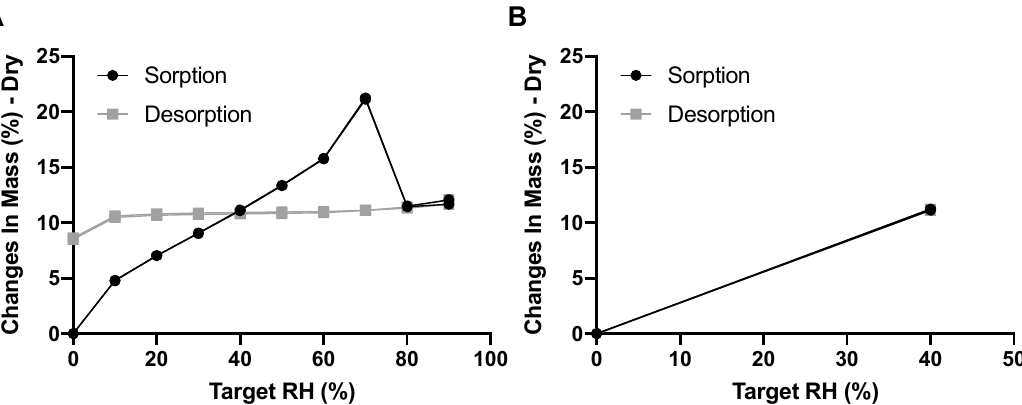
Figure 2. The DVS results for the amikacin formulation—panel ( A ) shows the sorption and desorption data from 0% to 90% RH and back in steps of 10% RH; panel ( B ) shows the data from 0% to 40% RH and back in steps of 40% RH ( n = 2, both replicates shown).